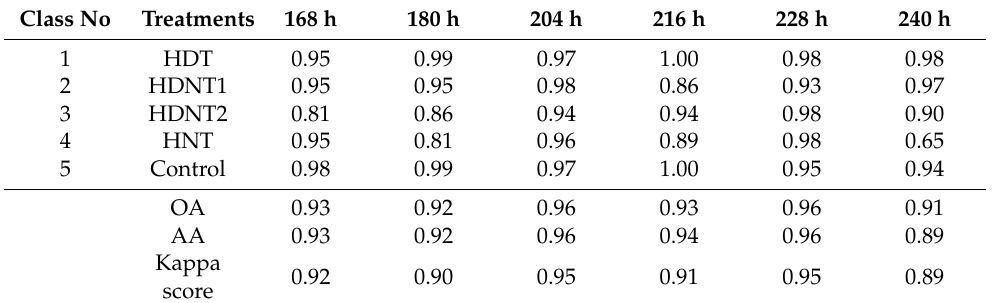
Table 10. Classification performance for rice HSI image datasets for different temperature treatments.